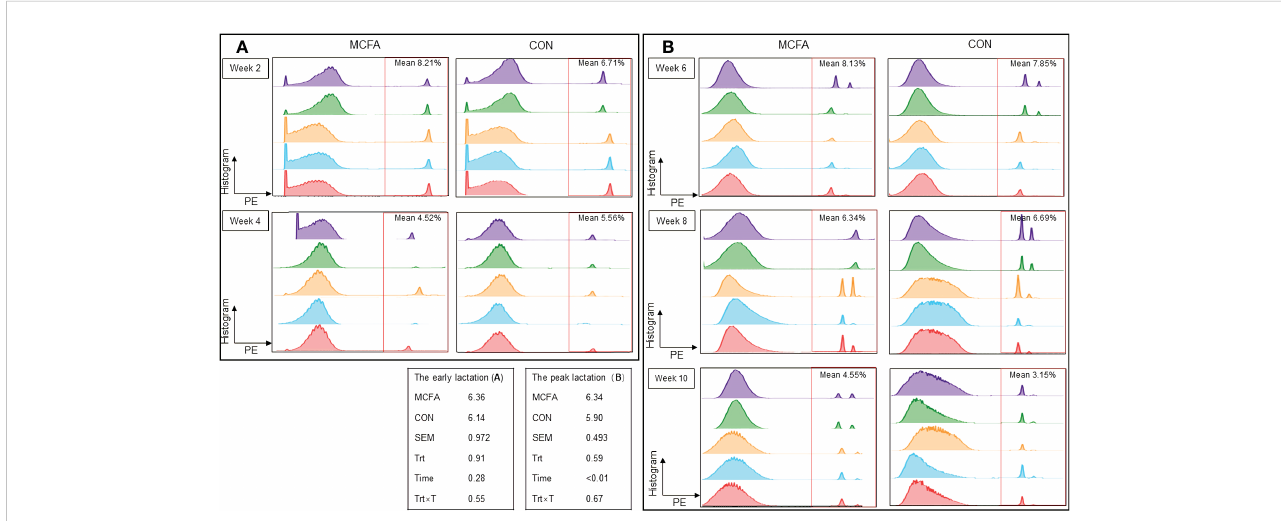
FIGURE 1 Effects of feeding medium chain fatty acid on blood neutrophils phagocytosis of the early lactation cows and the peak lactation cows. (A) The blood neutrophils phagocytosis of the early lactation dairy cows; (B) the blood neutrophils phagocytosis of the peak lactation dairy cows. CON, control treatment, n = 9; MCFA: MCFA treatment (basic diet and medium chain fatty acids 20 g/d), n = 9. SEM, standard error of mean. Trt, treatment effect; Time, the calving time effect; Trt × T, the interaction effect between treatment effect and time effect. The early lactation: from 1d to 28d after calving; the peak lactation: from 29 d to 70 d after